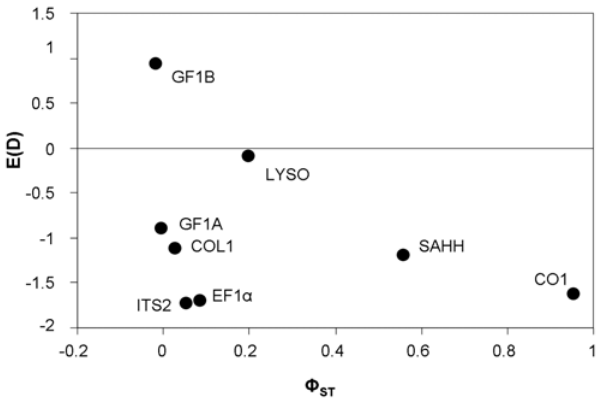
Figure 6. Average Tajima’s D values as a function of the W PhiST .